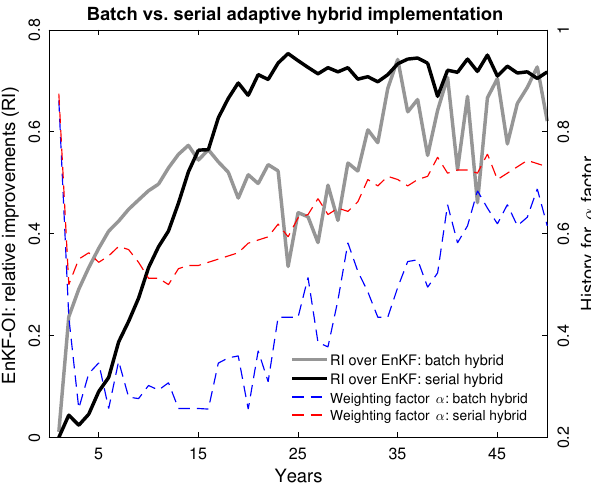
Figure 12. Left y axis: relative improvements (RIs) of the batch (i.e., observations processed all at once) and the serial (i.e, observa- tions processed one at a time) adaptive EnKF-OIs over the stan- dard EnKF scheme. RI is evaluated in time as follows: RI (t) = MSE EnKF (t) − MSE EnKF − OI (t) . Right y axis: time series for the opti- MSE EnKF (t) mized α values resulting from the batch and the serial (optimal α ’s from all observations are averaged)